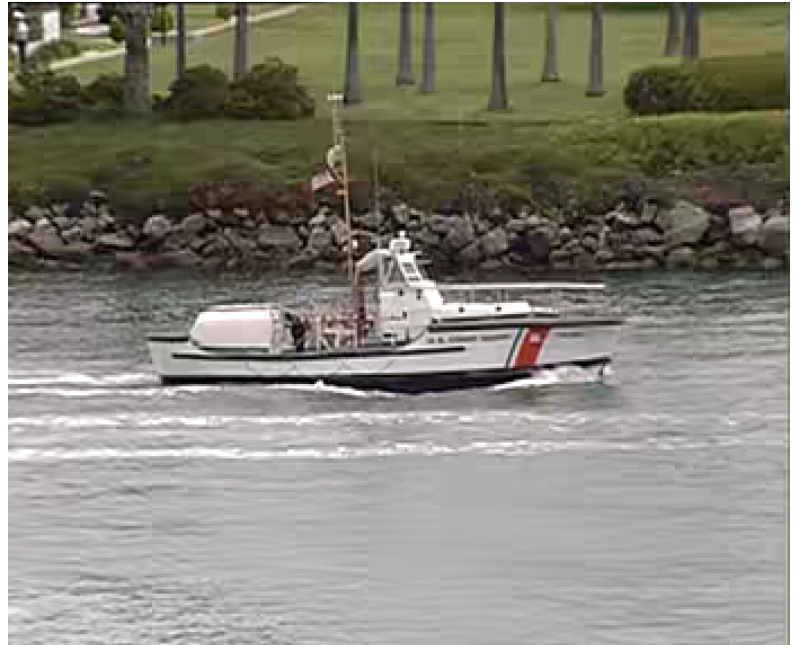
Figure 14. Frame of output video from HM with DBF